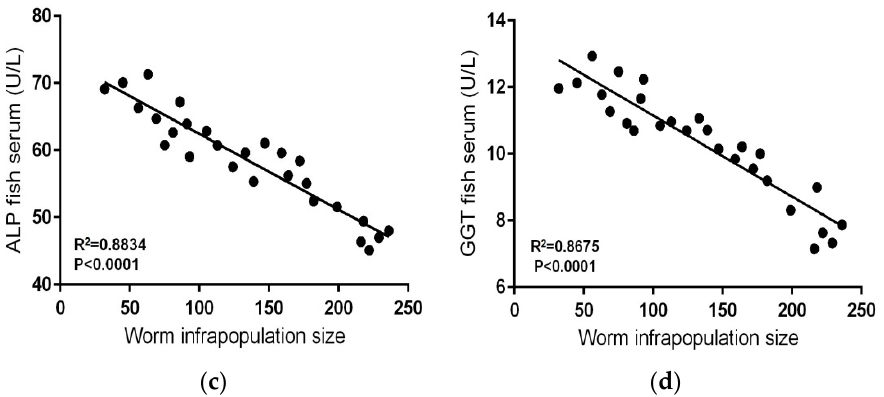
Figure 3. The relationships between levels of serum liver enzymes and worm infrapopulation size in fish intestine: ( a ) ALT level in fish serum vs. worm infrapopulation size, ( b ) AST level in fish serum vs. worm infrapopulation size, ( c ) ALP level in fish serum vs. worm infrapopulation size, ( d ) GGT level in fish serum vs. worm infrapopulation size.